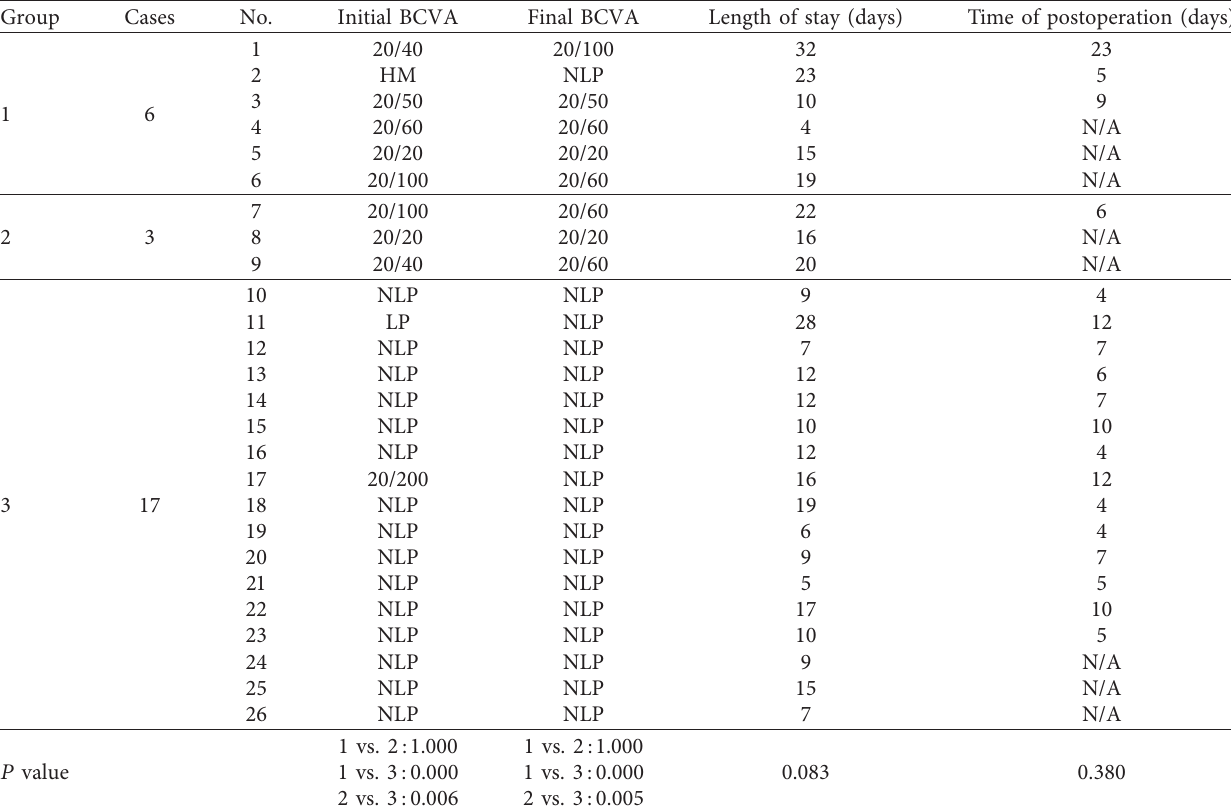
Table 5: The BCVA and length of stay of 26